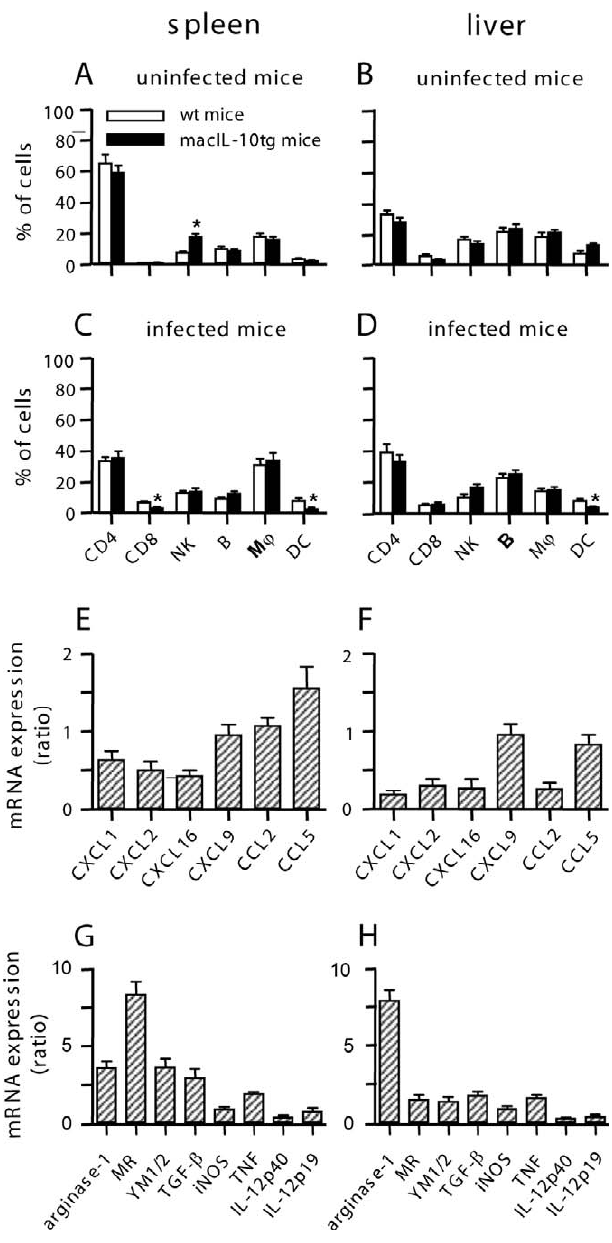
Figure 5. Tissue Recruitment of Leukocytes and Tissue Transcriptional Profile (A–D) The proportions of leukocyte subpopulations were determined by flow cytometry. Data are the mean 6 SD of three mice/time point. * p , 0.05. (E–H) Transcripts encoding chemokines (E and H) and molecules corresponding to M1 and M2 phenotype (G and H) were quantified by qRT-PCR. Results are expressed as the ratio of expression levels in macIL- 10tg mice and wt mice infected with C. burnetii for 14 d ( n ¼